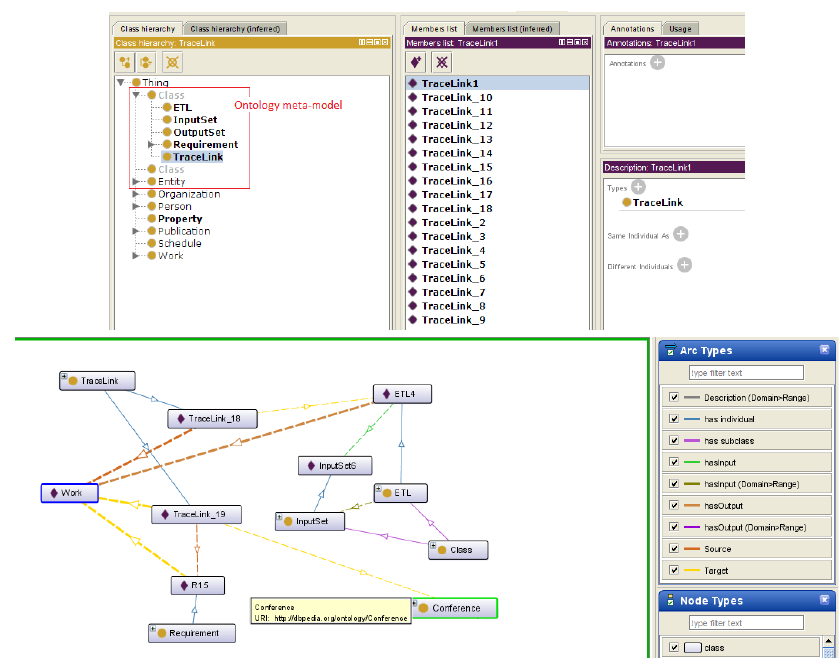
Figure 3. Traceability model and trace links (Protege